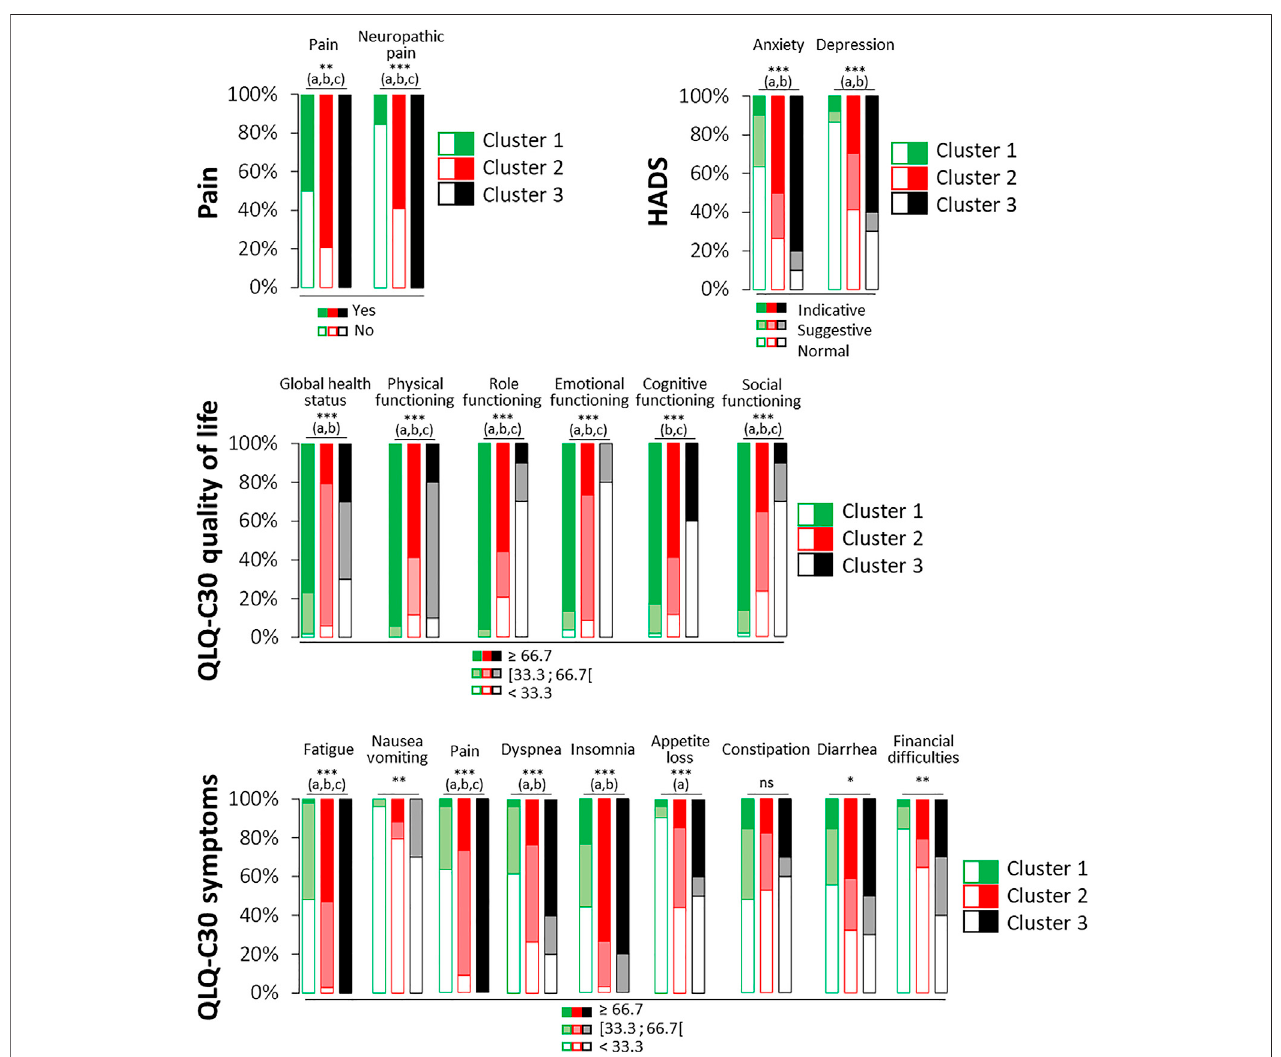
FIGURE 3 | Characteristics of pain, anxiety, depression and HRQOL among the four clusters of patients with a sensory CIPN. Anxiety and depression were assessed thanks to the HADS questionnaire and classi fi ed according to normal ( ≤ 7/21), suggestive (8 – 10/21) and indicative ( ≥ 11/21) scores of anxiety or depression. HRQOLwasassessedthankstotheQLQ-C30questionnaireandclassi fi edaccordingeachthirdofthescores( < 33.3[33.3 – 66.7[,and ≥ 66.7)fortheglobalhealthscale, the functional scales (physical, role functioning, emotional, cognitive, and social), and the symptomatic scales (fatigue, nausea/vomiting, dyspnea, insomnia, appetite loss, constipation, diarrhea, and fi nancial dif fi culties). Omnibus p -value: * p < 0.05; ** p < 0.01; *** p < 0.001; ns, not signi fi cant. Signi fi cant difference ( p < 0.05, post hoc analysis) between: a, cluster 1 and cluster 2; b, cluster 1 and cluster 3; c: cluster 2 and cluster